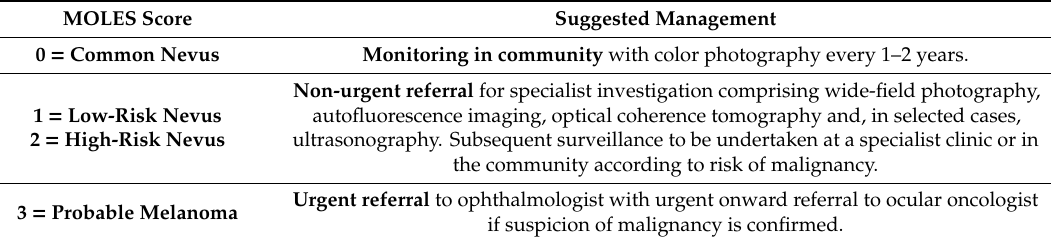
Table 2. MOLES tumor categories and recommended